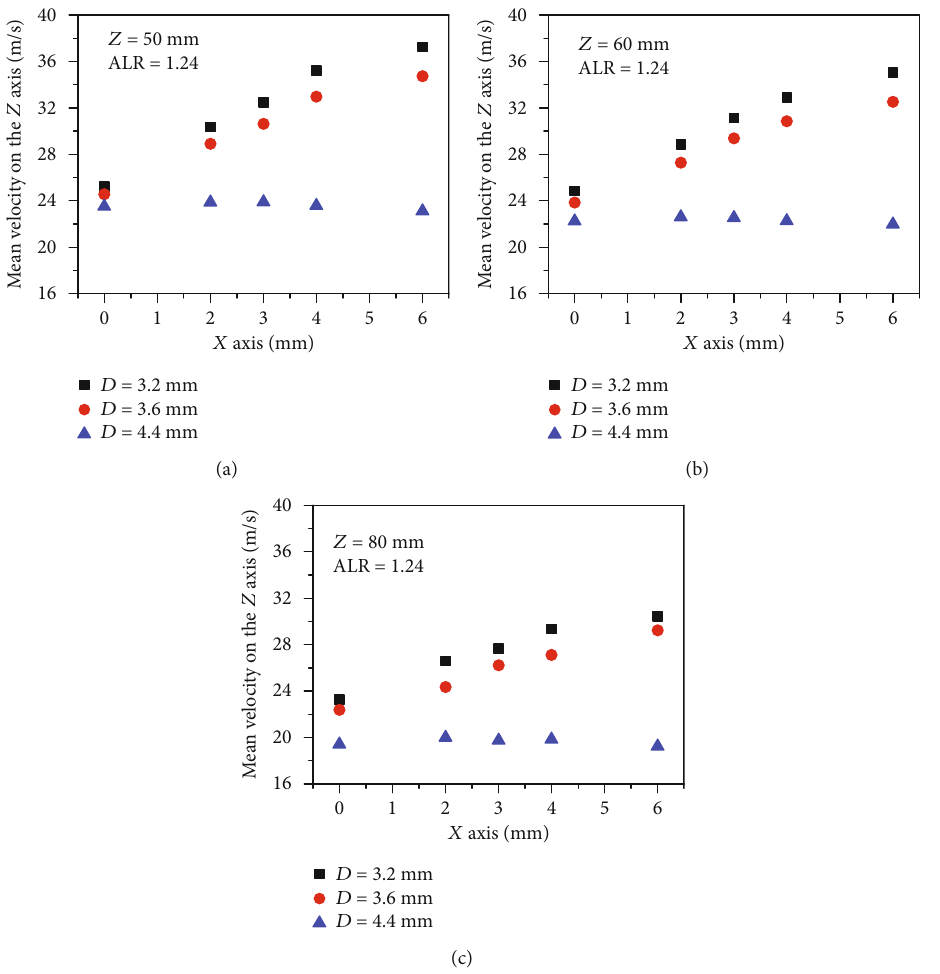
Figure 15: The droplet mean velocity on the Z axis of D series nozzle correlation at test position ( ALR = 1 : 24